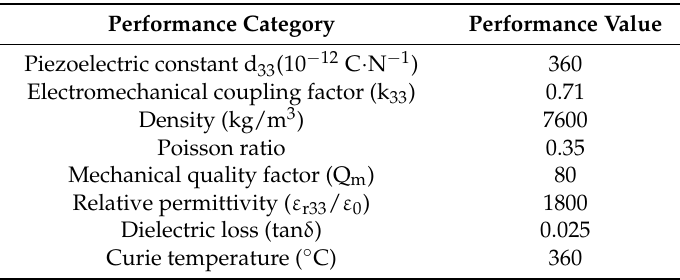
Figure 2. The surface bondable piezoceramic disk sensor. ( a ) The photo of piezoceramic disk; ( b ) Three-dimensional schematic of piezoceramic disk. Table 1. The parameters of PZT patch.